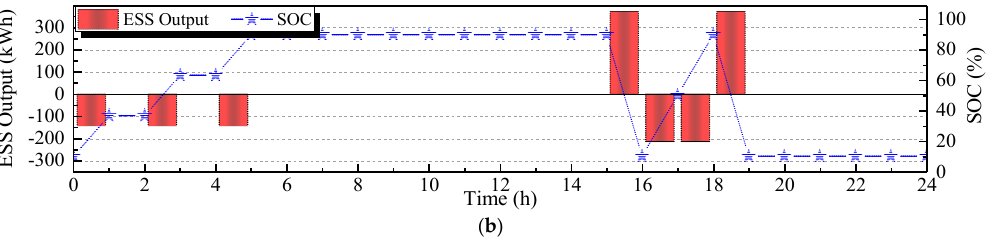
Figure A4. Results of Case 3: ( a ) Forecasted HOEP; ( b ) Scheduled output and SOC of the ESS. Case 4 The predicted peak demand of the customer, 1600 kW, was higher than the previous peak demand of 1550 kW, as shown in Figure A5a, and the forecasted HOEPs were lower than 0.017 $/kWh, as shown in Figure A5b. As λ PD was much higher than λ OP , the total costs could be decreased by reducing the peak demand. However, discharging that did not reduce the peak demand increased the costs, like in Case 1. Therefore, as shown in Figure A5c, the ESS was discharged in the time intervals where the predicted demand was larger than the previous peak demand, i.e., time intervals between 10 h and 11 h and between 12 h and 13 h. As discharging more in these intervals increased the costs, the ESS was only discharged when making the demands identical to the previous peak demand, i.e., the peak demand shown in Figure A5a was reduced to 1550 kW by discharging 50 kWh for each time interval.